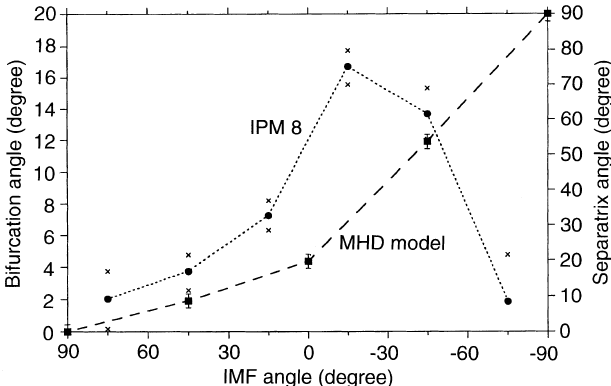
Fig. 4. Variation of the magnetopause rotation angle with IMF clock angle. Squares are the model values derived from Fedder et al . (1995) for comparison. The bars on the model values give the interval in which the separatrix angle changes within 2 (cid:176) for di(cid:128)erent initial conditions. Circles give the rotation angle of the magnetopause as observed in IMP 8 measurements as a function of IMF angle. The crosses above and below the observations give the 1 (cid:114) deviations (from Kaymaz et al . 1992). Note that the definition of the rotation angle is di(cid:128)erent in the model than that calculated for IMP 8 data as described in the text and shown in Fig. 5. However, in both cases the rotation angle increases as the IMF changes its orientation from north to south. The biggest rotation is seen for equatorial IMFs with a non- zero southward component. (See text for more detailed discussion of